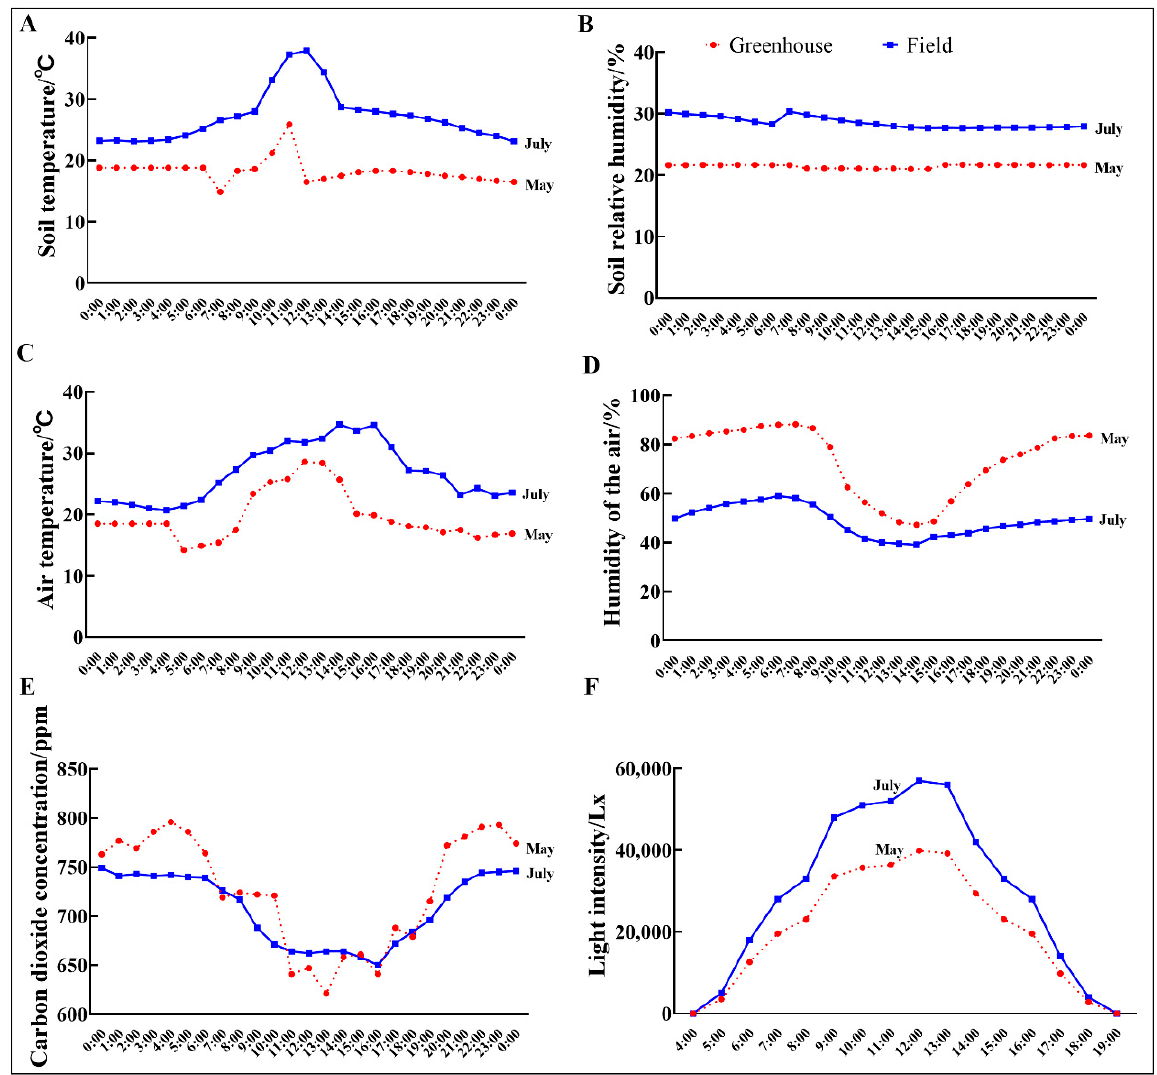
Figure 1. Diurnal variation in the field and greenhouse environments during fruit ripening. ( A – F ) present data on soil temperature, soil relative humidity, air temperature, air humidity, CO 2 concen- tration and light intensity, respectively. The measurement date in the greenhouse environment was 18 May, and that in the field environment was 27 July. Due to the similar diurnal variations in field and greenhouse environmental indicators at maturity, only the diurnal variation at harvest time is presented.